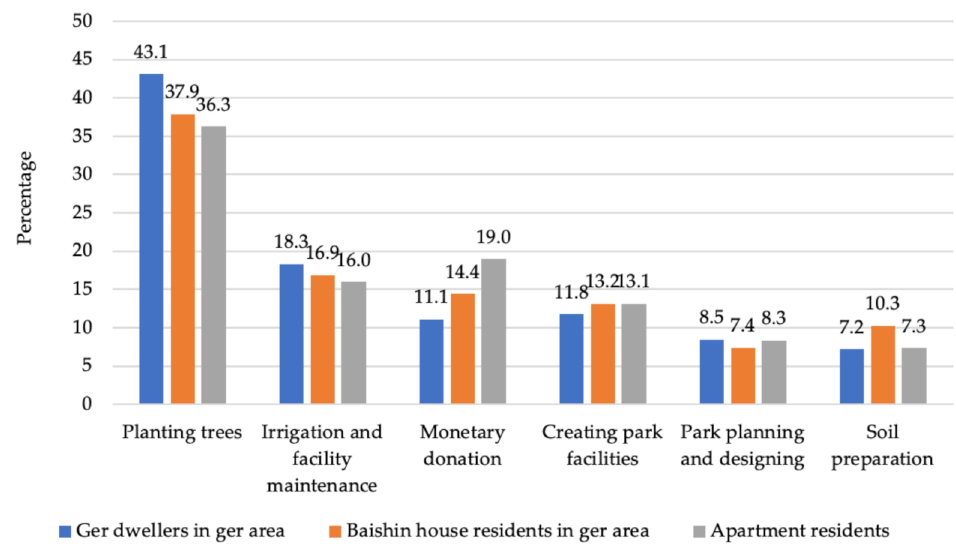
Figure 4. Respondents’ favored contributions to urban park establishment and